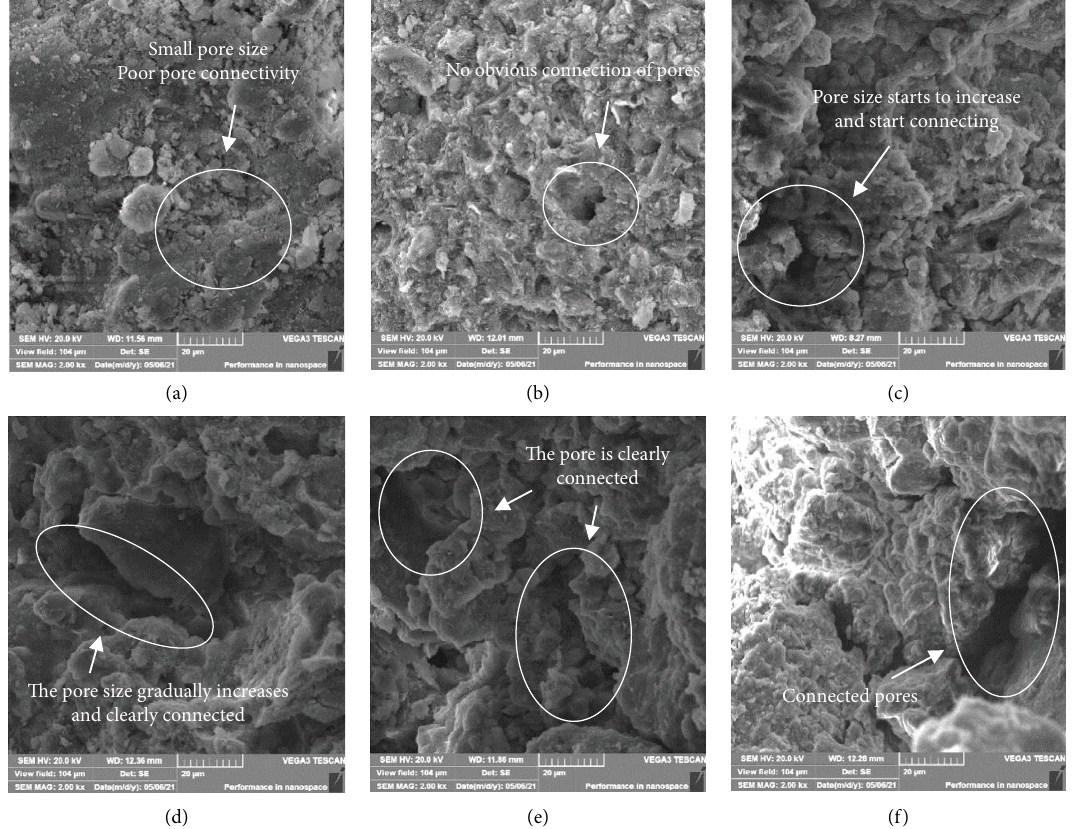
Figure 11: SEM images of samples with diferent contents of HA reagent ( × 2000): (a) 0% HA reagent; (b) 5% HA reagent; (c) 10% HA reagent; (e) 15% HA reagent; (f) 20% HA reagent; (g) 25% HA